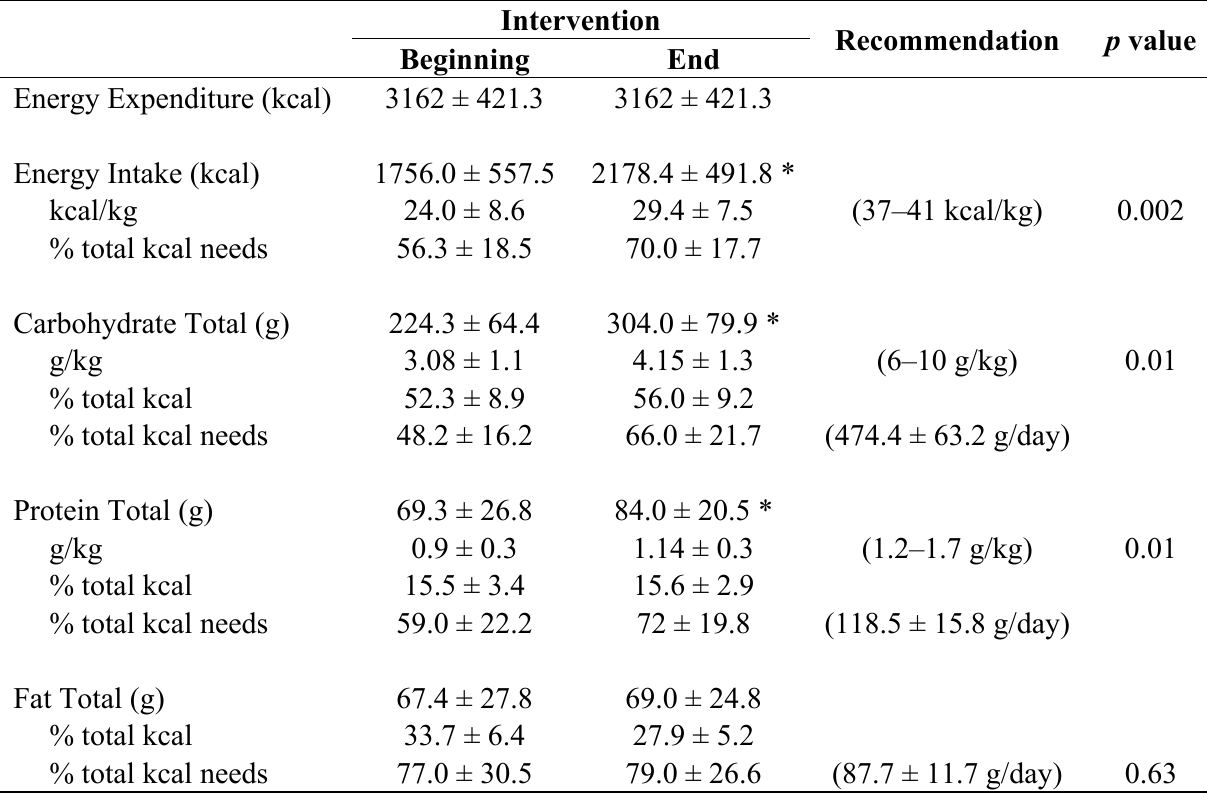
Table 2. Female volleyball players ( n = 11) intervention season beginning and end mean intakes of total energy and